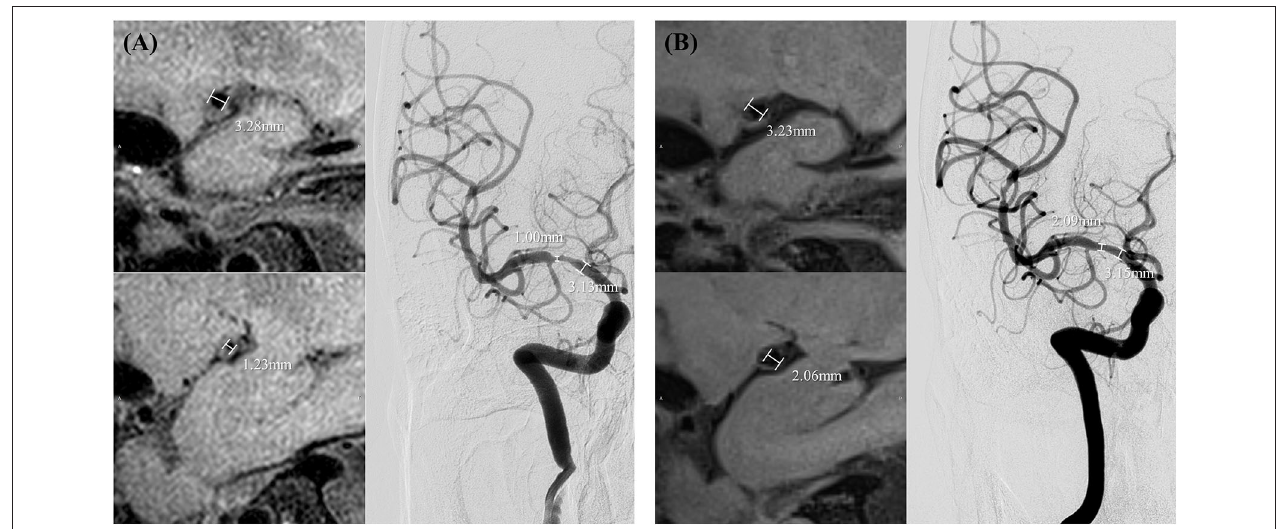
FIGURE 1 | Measurements of the degree of stenosis and minimal luminal diameter in preprocedural high-resolution magnetic resonance (HR-MR) and digital subtraction angiography (DSA) (A) and follow-up HR-MR and DSA (B) .